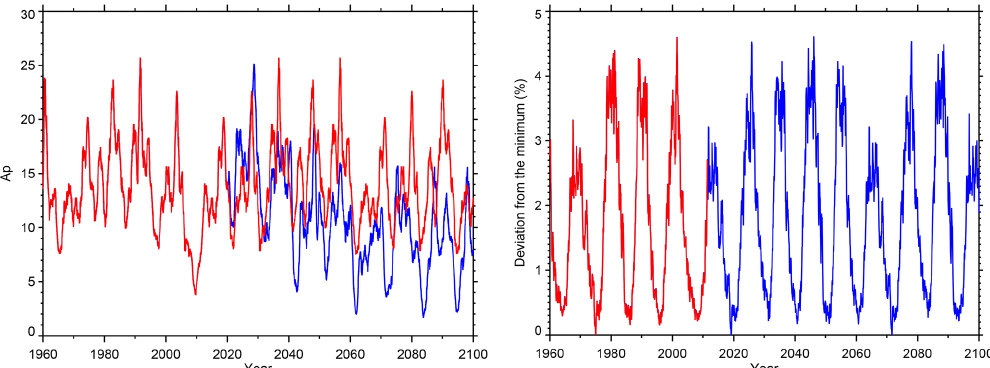
Figure 6. (left) Recommended A p index time series for SEN-C2_SolarTrend (blue) and the other reference and sensitivity simulations (red). The data are smoothed with 360-day-wide window. (right) Deviation (%) of the recommended monthly mean solar irradiance for the 175–250nm spectral band from its minimum value, to be used in all simulations. Red: prior to and including 2010, the data are based on observations. Blue: projected solar irradiance